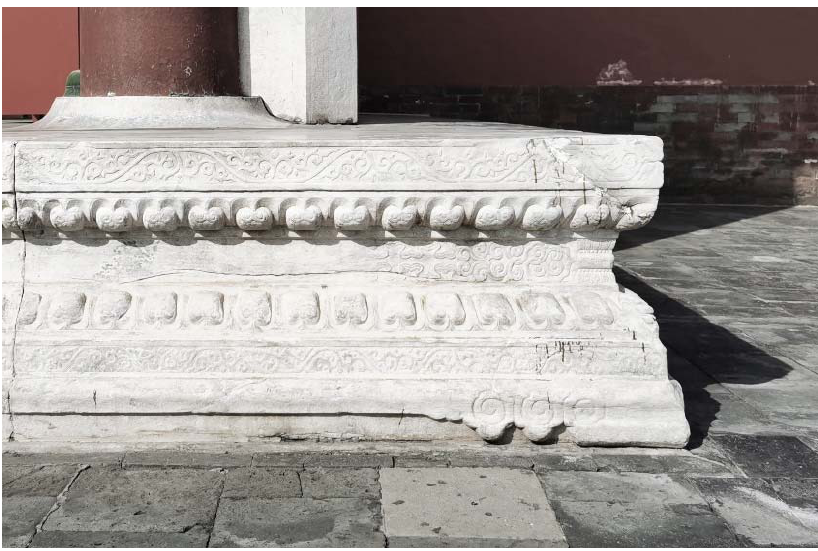
Figure 16. A corner of the white marble base of the Hall of Supreme Harmony in the Forbidden Palace, Beijing, China, seventeenth century (Photo by author, 15 October 2021).